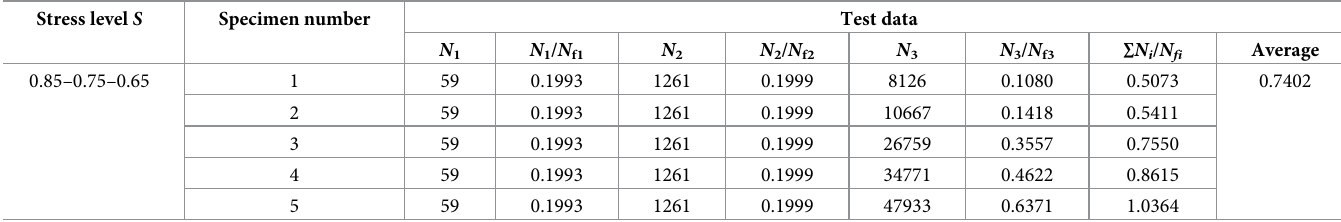
Table 15. Test results of flexural fatigue damage of concrete under three-stage loading (high-low order). Stress level S